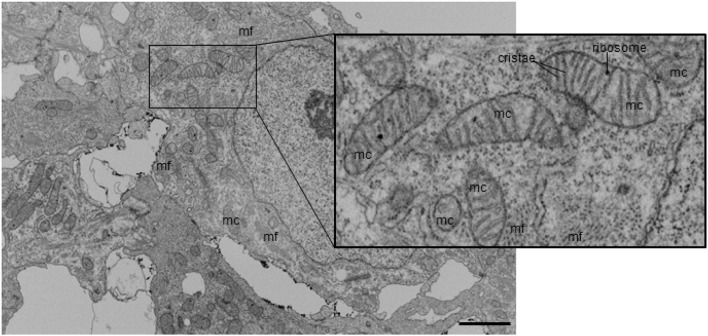
Example FIB-SEM image showing mitochondria among myofibrils in control outflow tract myocardium tissue. Myofibrils are arranged in both circumferential and radial orientations. Mc, mitochondria; mf, myofibril. Scale bar = 5 μm.